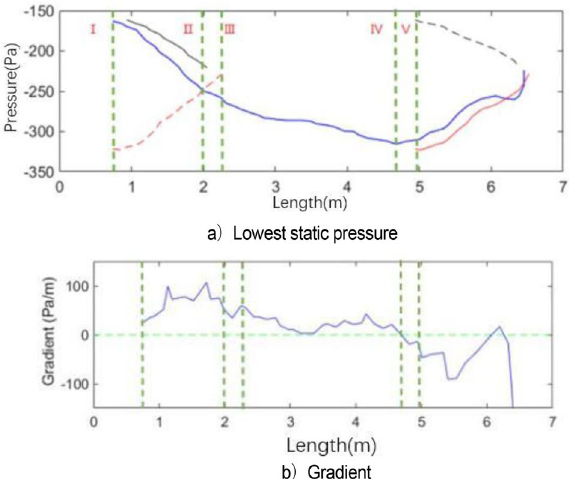
Figure 15. Evolution of vortex (The blue line represents the "current vortex", the red line represents the old vortex, and the black line represents the new vortex. The solid line represents the actual vortex structure in the current period. The red dotted line represents the old vortex which is moved to the timeline of the "current vortex". The same goes for black dotted lines. The green dotted line represents the key time node of vortex evolution in the current